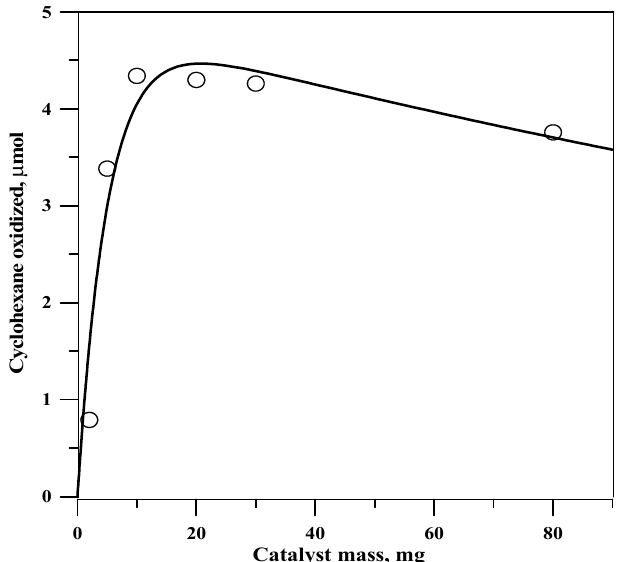
Figure 2. Total yield of oxidized products from the irradiation (100 W Hg lamp, λ > 360 nm) of stirred suspensions of Et 4 N[FeCl 4 ] in 1.0 mL of cyclohexane (with 0.5% acetic acid and 1 mg Bu 4 NBr) as a function of the amount of catalyst employed. Solid line is a fit to Equation (6) with β = 0.20, γ = 0.99, and δ = 0.0035.